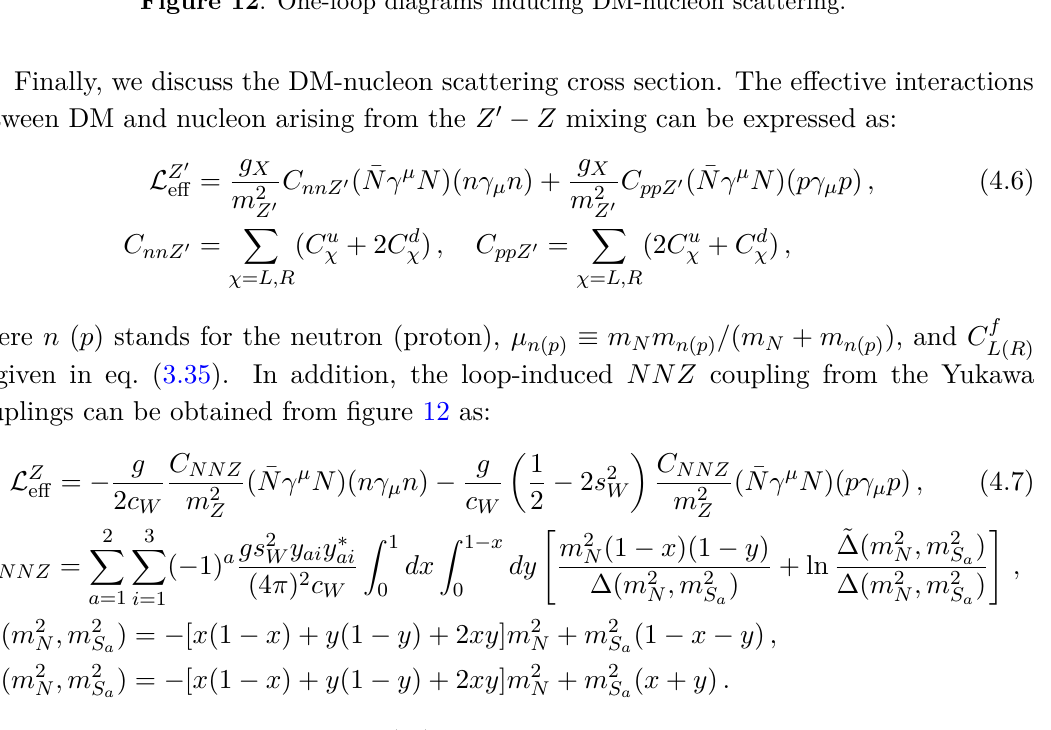
Figure 12 . One-loop diagrams inducing DM-nucleon